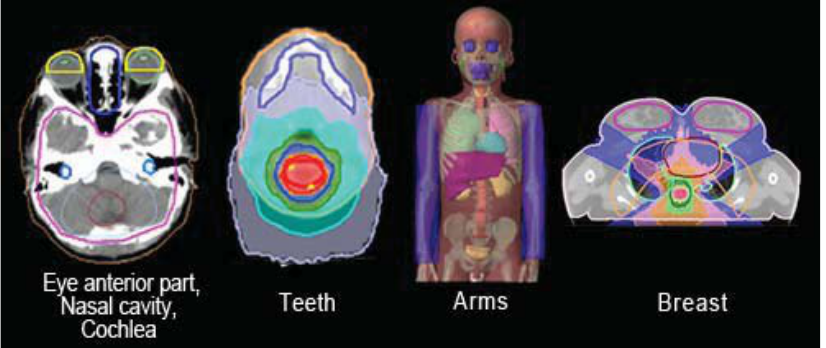
Figure 1. An example of contouring of different OARs marked during the HT process: anterior part of the orbits, nasal cavity, cochlea, teeth, arms,